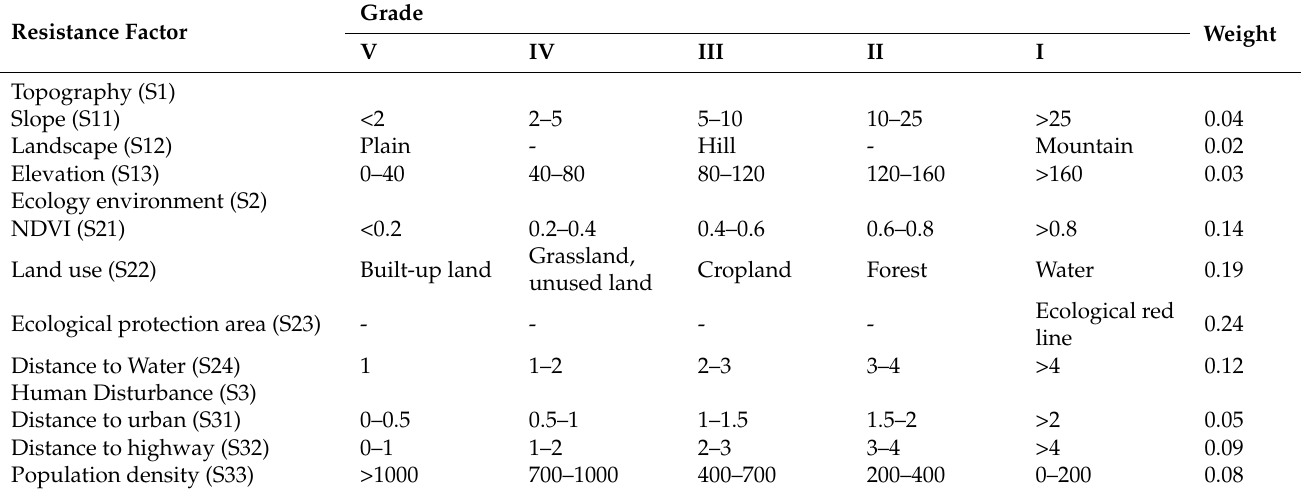
Table 2. The value of resistance assignment for built-up land and non-built-up